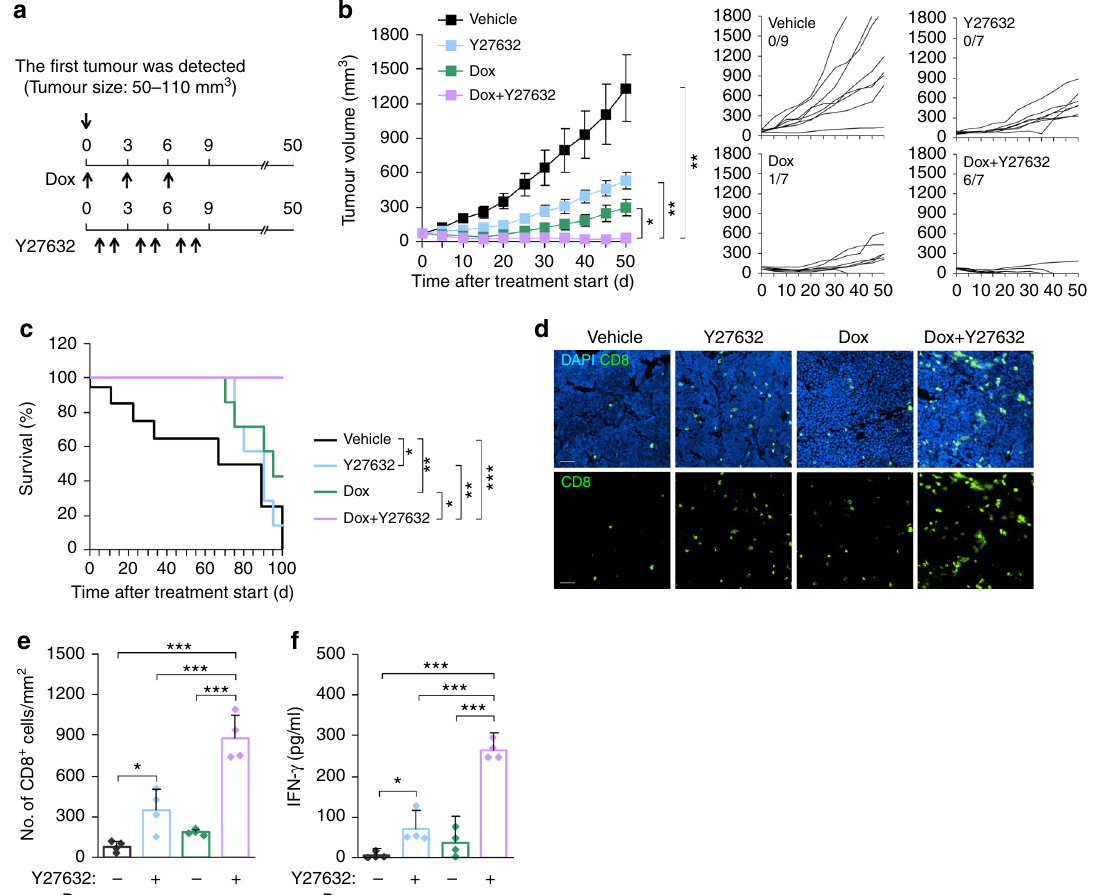
Fig. 7 Combined therapy is effective in a genetic tumour model. a Schematic diagram of experiments for investigating the combined effect of Y27632 and Dox on tumour growth in a genetically engineered tumour model. b Tumour-bearing MMTV/Neu mice were injected (i.v.) with Y27632 (10 mg kg − 1 ) and/ or Dox (5 mg kg − 1 ) as indicated in a . Tumour size was measured at the indicated times. Data are presented as means± s.e.m ( n = 7 – 9) (left panel) and tumour growth curves of individual mice (right panels). Fractions indicate the number of mice showing complete tumour regression. c Survival of tumour- bearing MMTV/Neu mice following combined therapy ( n = 7 – 9). d , e MMTV/Neu mice bearing tumours were injected (i.v.) with Y27632 and/or Dox. On day 5 after Dox and/or Y27632 treatment, CD8 + T cells in tumours were stained with an anti-CD8 antibody. d Representative result. Scale bar, 50 μ m. e Number of CD8 + T cells per mm 2 . Data are presented as means± s.d. ( n = 4). f On day 5 after Dox and/or Y27632 treatment, single-cell suspensions from spleen were stimulated with rat Neu-derived peptide for 48 h, and IFN- γ production was measured by ELISA. Data are presented as means ± s.d. ( n = 4). * P < 0.05, ** P < 0.01, *** P < 0.001; signi fi cance determined by Kruskal – Wallis test with Bonferroni correction ( b ), log-rank test ( c ), or one-way